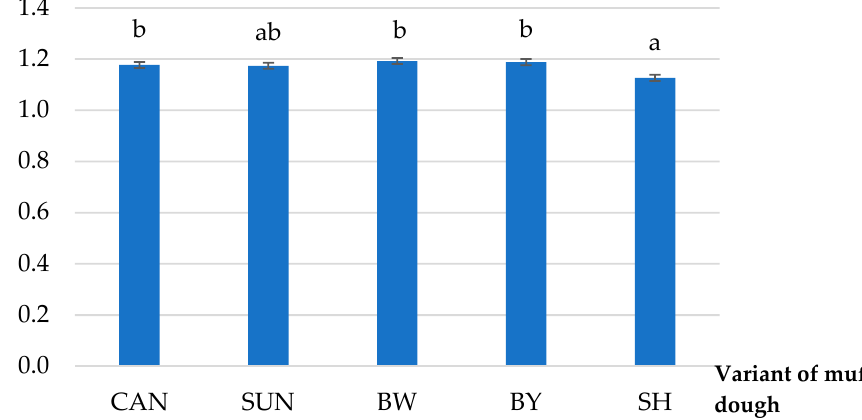
Figure 1. Specific gravity of gluten-free-muffin dough (g/cm 3 ), which contained shortening (SH) or oleogel made with the addition of a single wax: candelilla (CAN), sunflower (SUN), beeswax white (BW), or yellow (BY); a, b—different letters above each column indicate statistical difference at α = 0.05. Table 1. Specification of the waxes used in the production of oleogels (manufacturer’s information) Parameter Type of Wax Candelilla Sunflower Beeswax White Beeswax Yellow